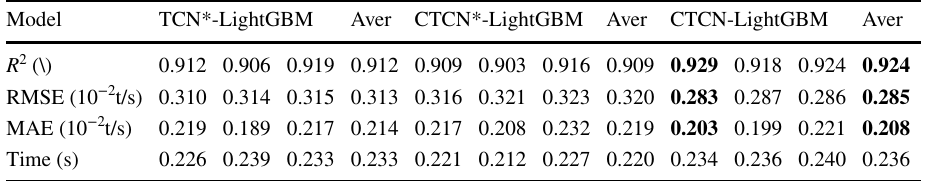
The bold values indicate superior metric values of the proposed CTCN-LightGBM Table 12 Classification results of each model for the chute flow adjustment